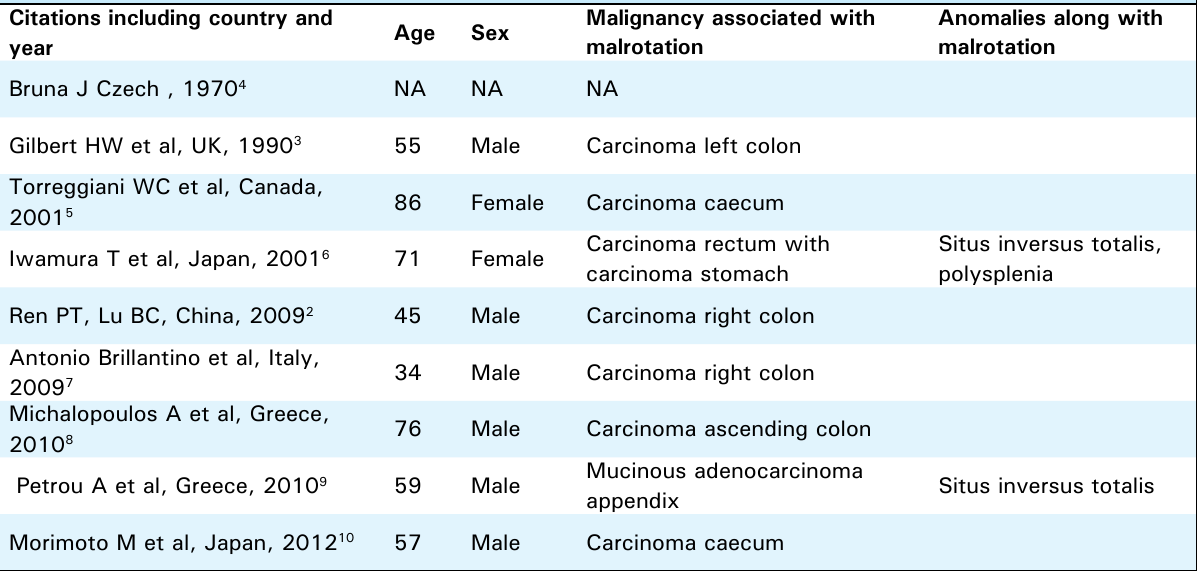
table 1. Incidences of colorectal cancers in malrotation of intestine in adults. citations including country